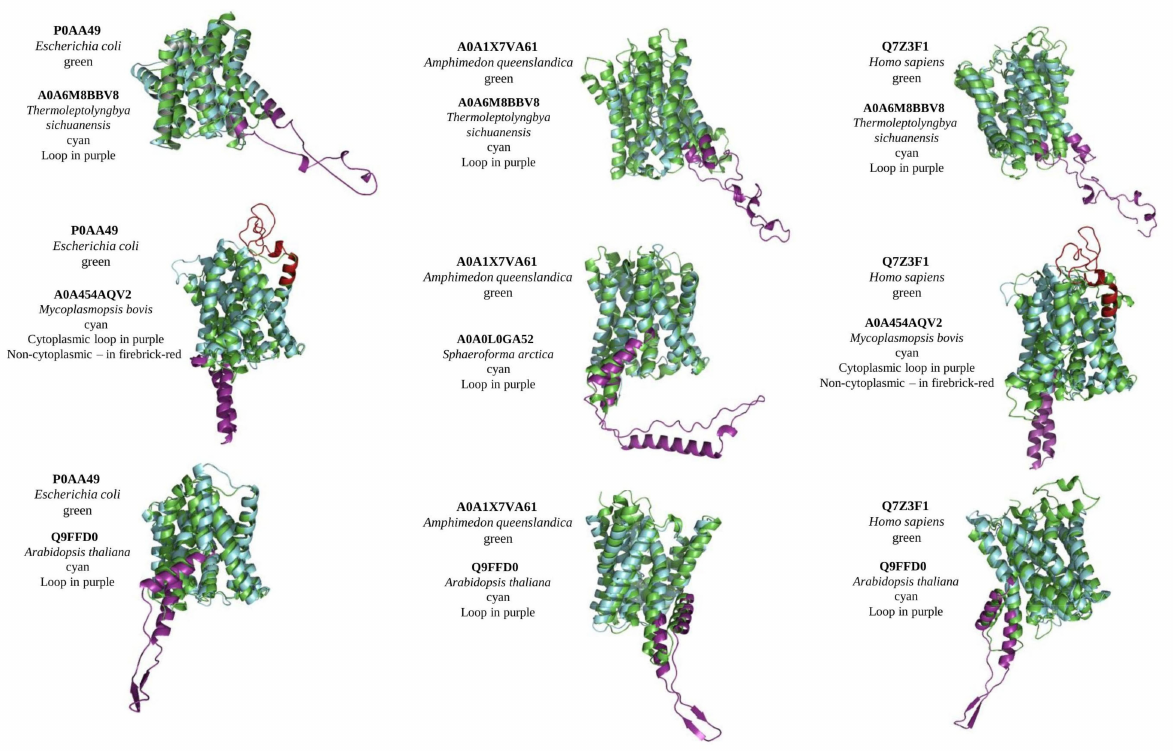
Figure 2. Alignment of structural models of MTP domain-containing proteins from different taxa. Control proteins (green) (with no loops) from bacteria Escherichia coli , sponge Amphimedon queens- landica , and Homo sapiens were aligned with MTPs with loops (cyan) from cyanobacteria Thermolep- tolyngbya sichuanensis (alignment scores 112, 113, and 112 for every control, respectively), terrabacteria Mycoplasmopsis bovis (alignment scores 166 and 169), a unicellular eukaryote Sphaeroforma arctica (align- ment score 148), and plant Arabidopsis thaliana (alignment scores 317, 362, and 289). Non-cytoplasmic loop represented with firebrick-red, cytoplasmic with purple colours.